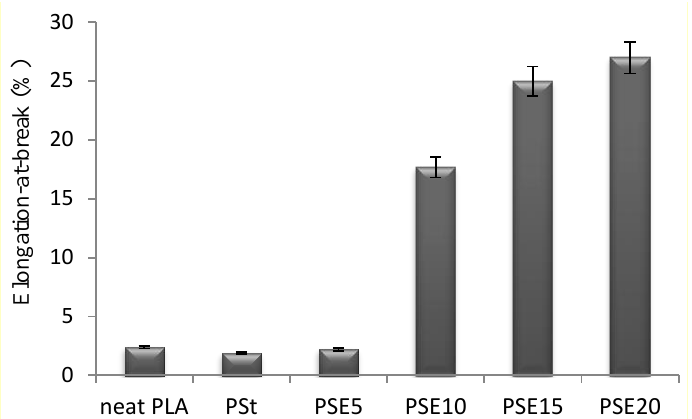
Figure 5. Elongation-at-break of neat PLA, PSt, and PSE blends.